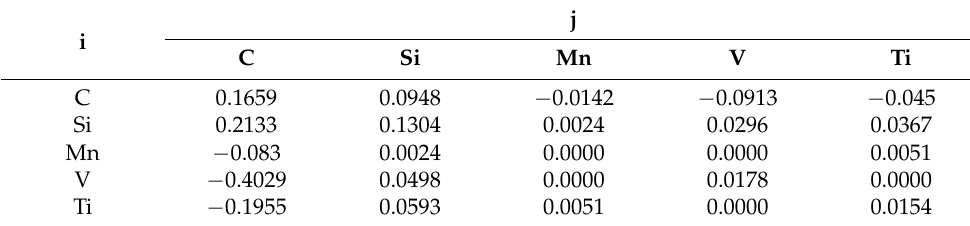
Table 2. Interaction coefficients of solute elements in metal.